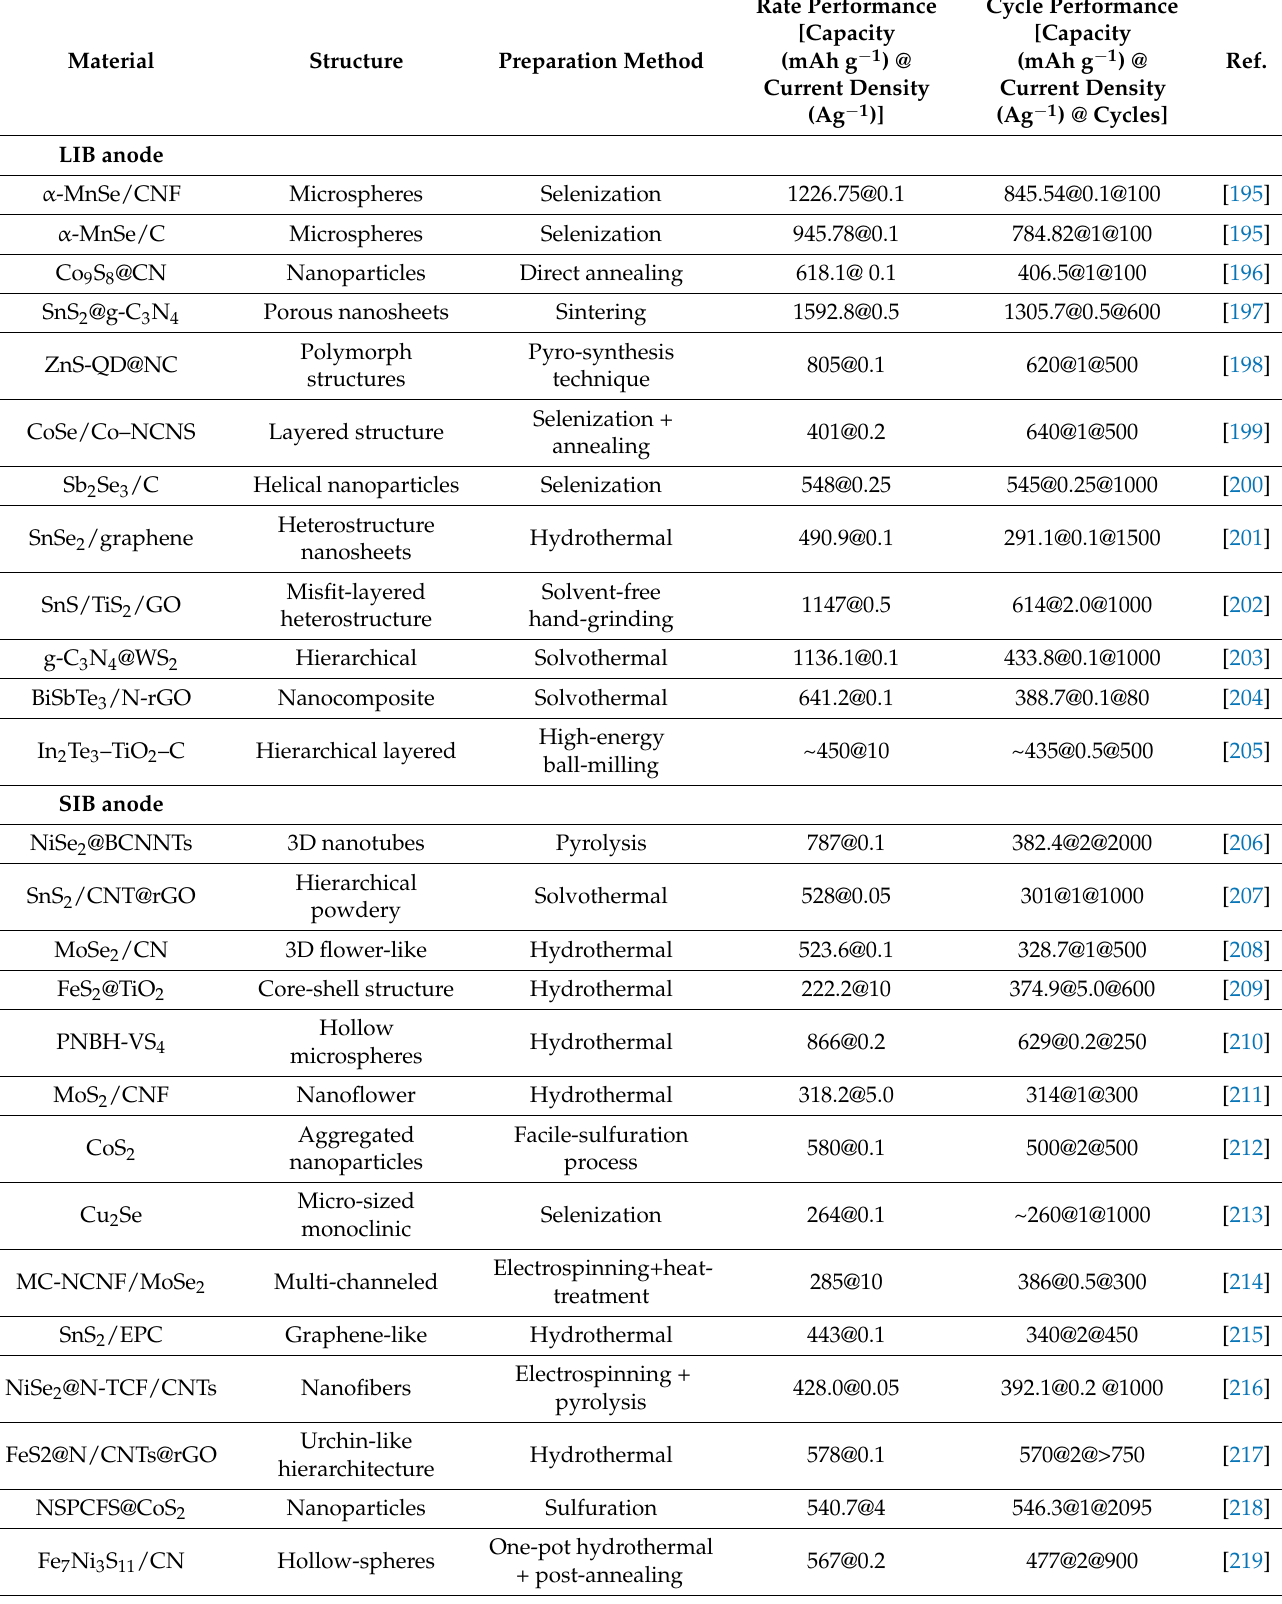
Table 4. Electrochemical performance of some common MIBs in